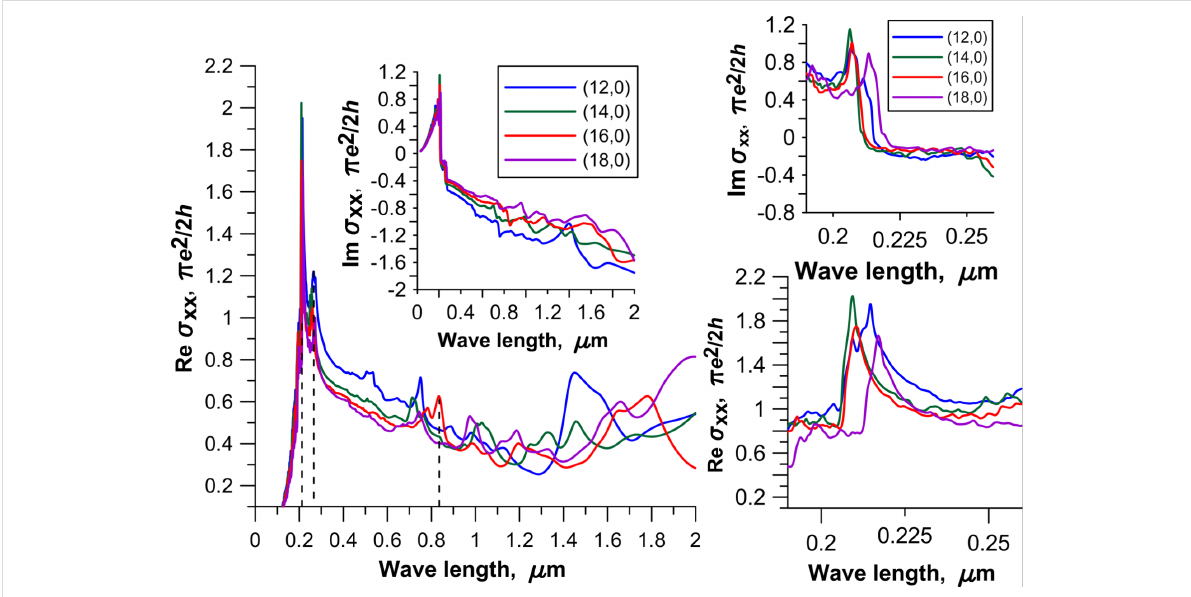
Figure 3: The optical conductivity of 2D CNT–graphene hybrid nanocomposites with an intertube distance of 13 hexagons in the direction perpendicu- lar to the nanotube axis. The insets on the right side show the graphs of optical conductivity for the wavelength range of 190–260 nm.